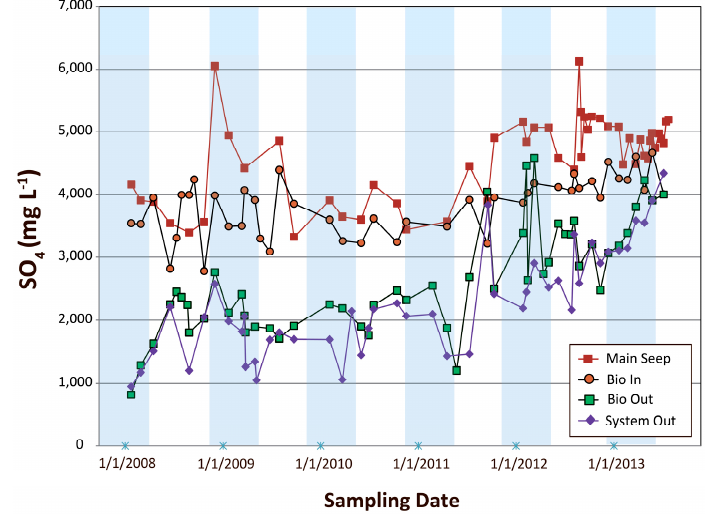
Figure 6. Temporal trends for the concentrations of dissolved sulfate (SO 42 − ) in water samples collected at the Main Seep, Bioreactor Inlet (Bio In), Bioreactor Outlet (Bio Out), and the System Outlet (System